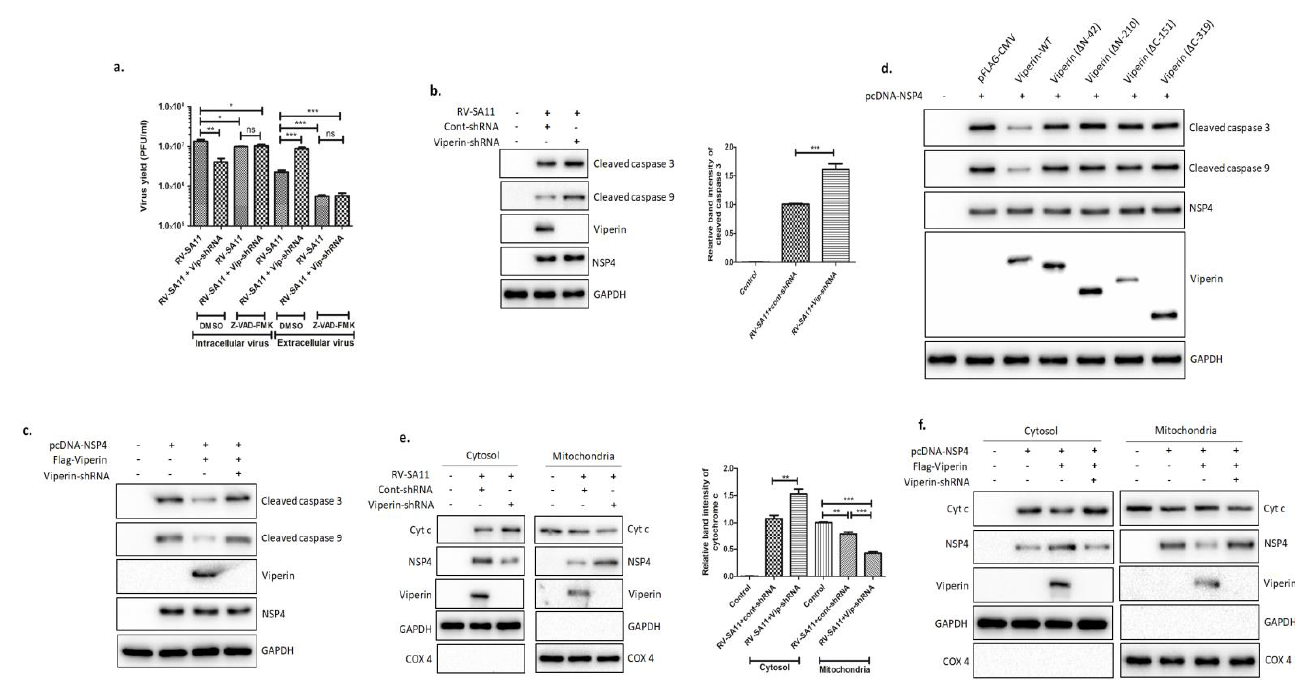
Figure 6. Viperin restricted the RV-induced intrinsic apoptosis pathway by impeding the translocation of NSP4 to the mitochondria. ( a ) HT-29 cells, transfected with either cont-shRNA or vip-shRNA, were infected with RV-SA11 in the presence of DMSO or Z-VAD-FMK (10 µM) and incubated for 24 h. After incubation, both intracellular and extracellular viruses were collected and used to measure viral titers by plaque assay. Data represent mean virus particles ± SD of three independent experiments; *** represents p ≤ 0.001, ** represents p ≤ 0.01, * represents p ≤ 0.05, n represents p value non-significant, unpaired Student’s t -test. ( b ) Whole cell lysates of RV-SA11-infected HT-29 cells (12 hpi), pre-transfected with either cont-shRNA or vip-shRNA, were assessed by western blot to check expressions of cleaved caspase 3, cleaved caspase 9, viperin, NSP4 and GAPDH. NSP4 and GAPDH served the purpose of the infection marker and the internal loading control, respectively. Relative band intensities of cleaved caspase 3 are also presented. Data represent mean band intensity ± SD of three independent experiments; *** represents p ≤ 0.001, unpaired S tudent’s t -test. ( c ) HEK-293 cells were transfected with vectors encoding only NSP4; NSP4 and FLAG-viperin; or NSP4, FLAG-viperin and vip-shRNA. After 36 h of incubation, cell lysates were prepared and subjected to western blot analysis by using anti-cleaved caspase 3, an- ti-cleaved caspase 9, anti-viperin, anti-NSP4 and anti-GAPDH antibodies. ( d ) HEK-293 cells were transfected with pcDNA-NSP4 along with FLAG-tagged wild- type viperin, ΔN - 42, ΔN - 210, ΔC - 151 or ΔC -319 and incubated for 36 h. Next, cell lysates were prepared and subjected to western blot to check expressions of cleaved caspase 3, cleaved caspase 9, NSP4, viperin and GAPDH. ( e ) HT-29 cells, transfected with either cont-shRNA or vip-shRNA, were infected with RV-SA11 at an MOI of 3 and incubated for 12 h. After incubation, cells were collected and used to isolate cytosolic and mitochondrial fractions. Next, both fractions were subjected to western blot analysis to check expressions of Cyt c, NSP4, viperin, GAPDH and COX 4. COX 4 and GAPDH were used as both the markers and the internal loading controls of the mitochondrial fraction and the cytosolic fraction, respectively. Relative band intensities of cleaved cytochrome c in the cytosolic and mitochondrial fraction are also presented. Data represent mean band intensity ± SD of three independent experiments; *** represents p ≤ 0.001, ** represents p ≤ 0.01, unpaired S tudent’s t -test. ( f ) Cytosolic and mitochondrial fractions of HEK-293 cells, transfected with vectors encoding only NSP4; NSP4 and FLAG-viperin; or NSP4, FLAG-viperin and vip-shRNA were used to assess the expressions of Cyt c, NSP4, viperin, GAPDH and COX 4 by west- ern blot. COX 4 and GAPDH were used as both the markers and the internal loading controls of the mitochondrial frac- tion and the cytosolic fraction, respectively.